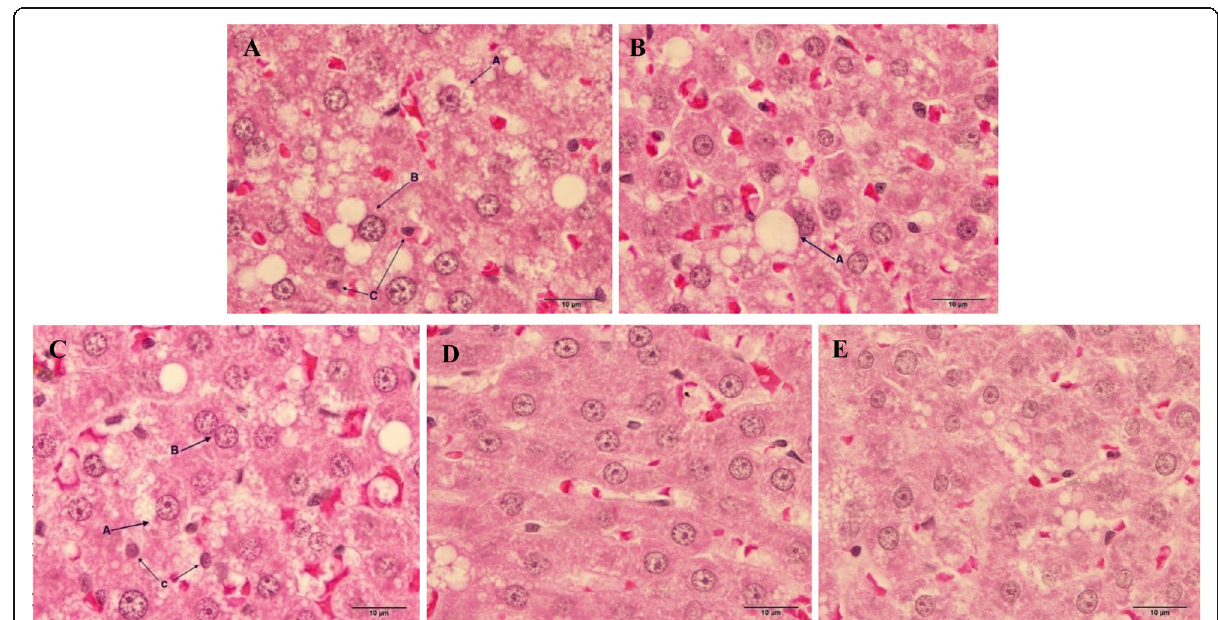
Fig. 5 Light microscopic pathology of liver tissue of rat. H&E stain with magnification of × 100 of objective lens. a Rat in HF group. AA, microvesicular steatosis; AB, macrovesicular steatosis; AC, pyknotic nucleus (nucleus condensation). b Rat in ML group for 12 weeks. BA, macrovesicular steatosis. c Rat in MM group. CA, microvesicular steatosis; CB, binuclear hepatocyte and karyorrhexis nucleus (nuclear fragmentation); CC, pyknotic nucleus (nucleus condensation). d Rat fed in MH group. e Rat in STAT